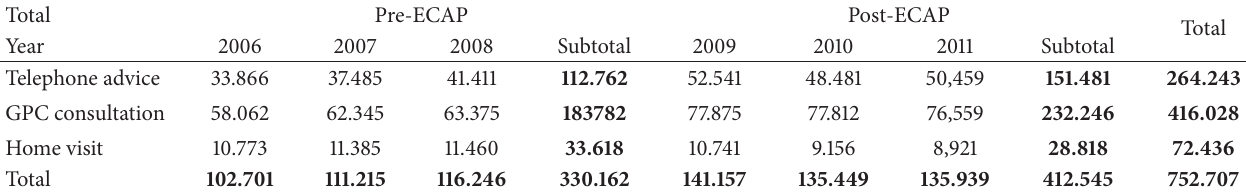
Table 3: Patient numbers at the regional GPC before and after the ECAP (after